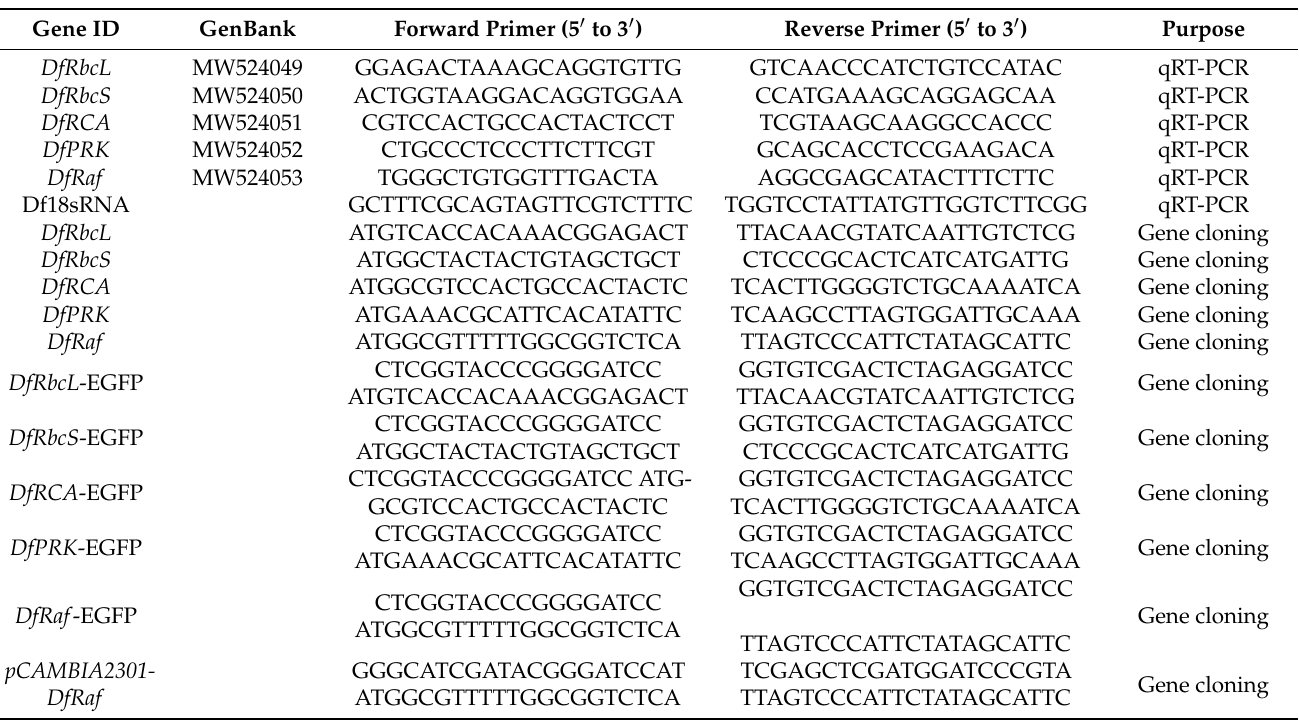
Table 1. Primers for carbon assimilation-related